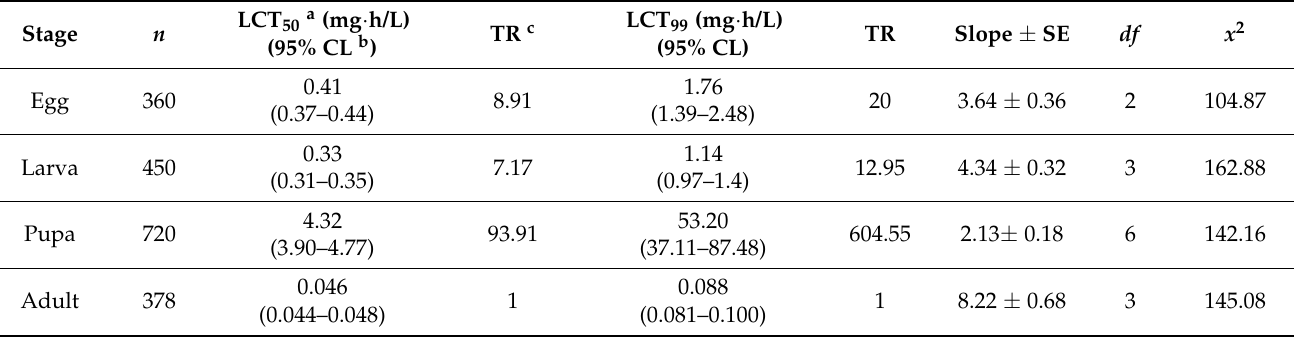
Table 1. Fumigation effect of PH 3 against all D . suzukii developmental stages in a 12 L desiccator after 4 h of exposure at 20 ◦ C.